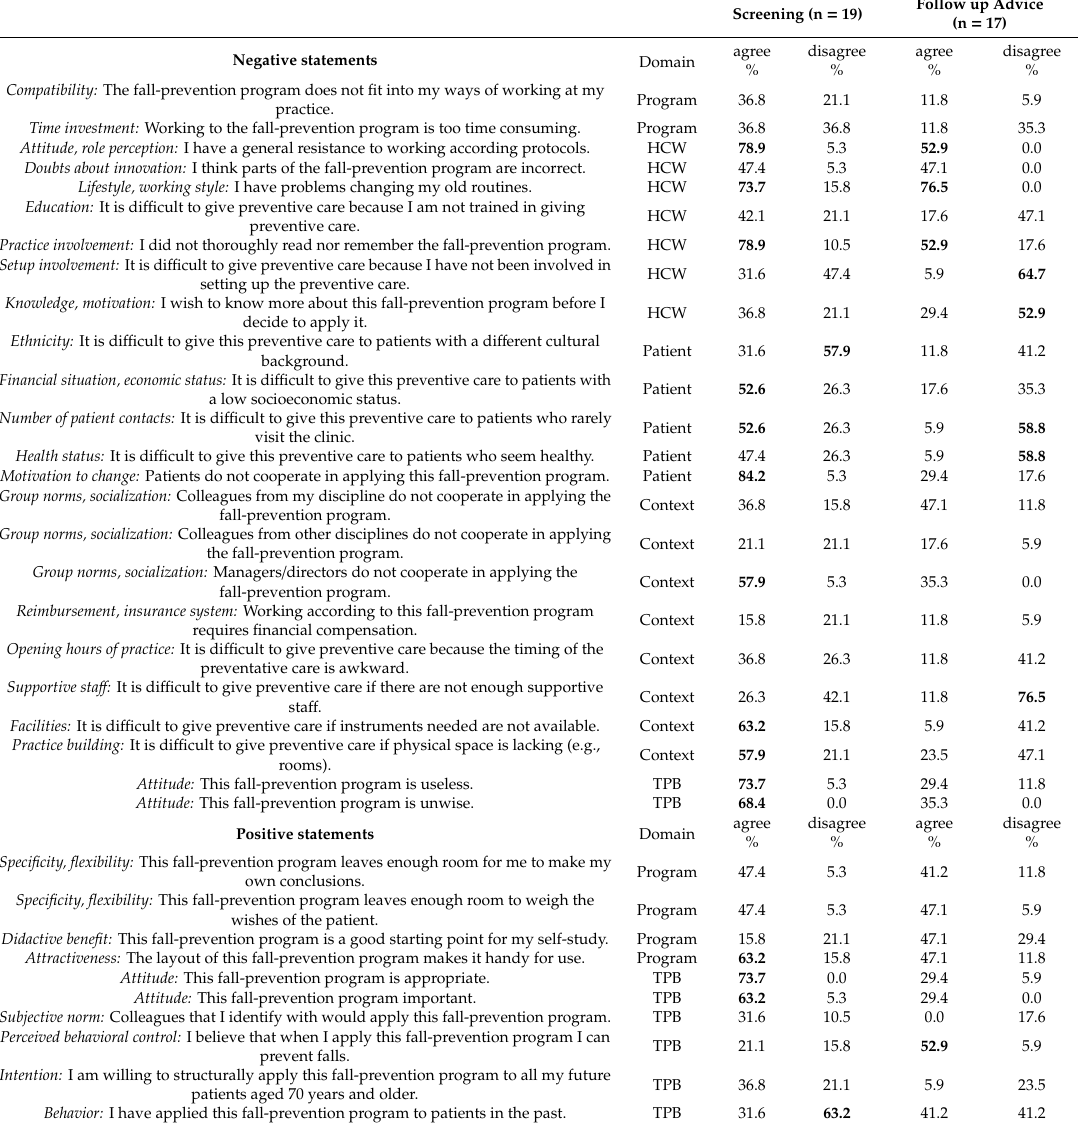
Table 3. Barriers and facilitators of healthcare providers to implementing the fall screening program in older adults.